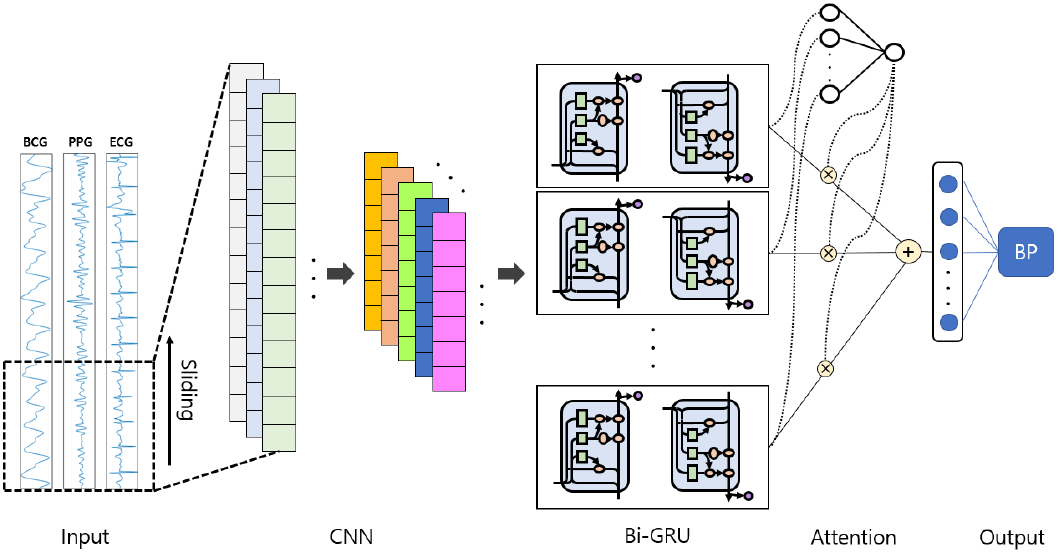
Figure 7. Overall structure of the proposed